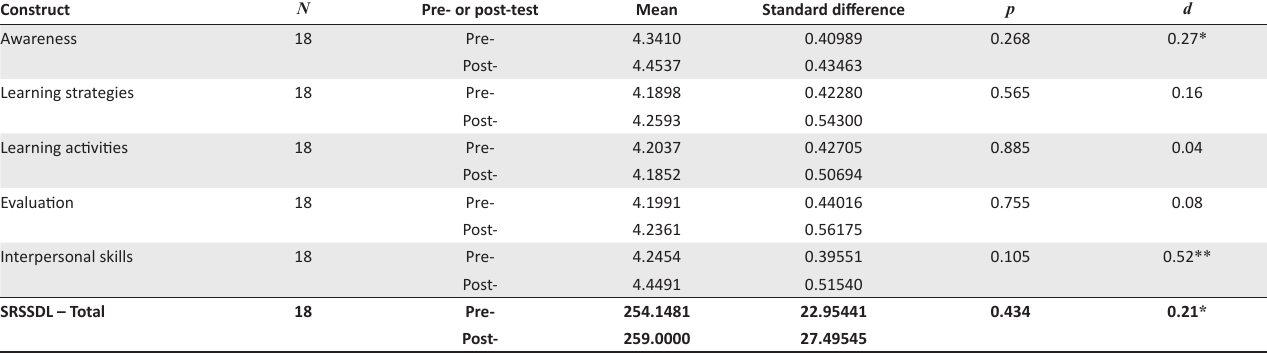
TABLE 4: Self-rating scale of self-directed learning – Pre-test and post-test (Group 2). Construct N Pre- or post-test Mean Standard difference p Awareness